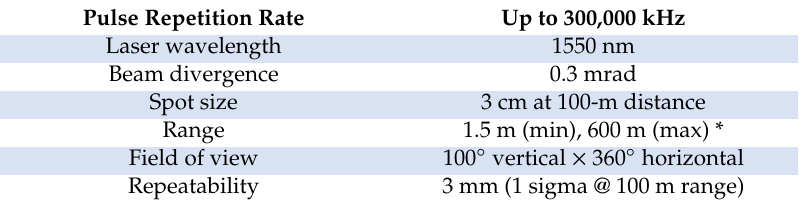
Table 1. Factory specifications of the Riegl VZ-400 terrestrial laser scanner